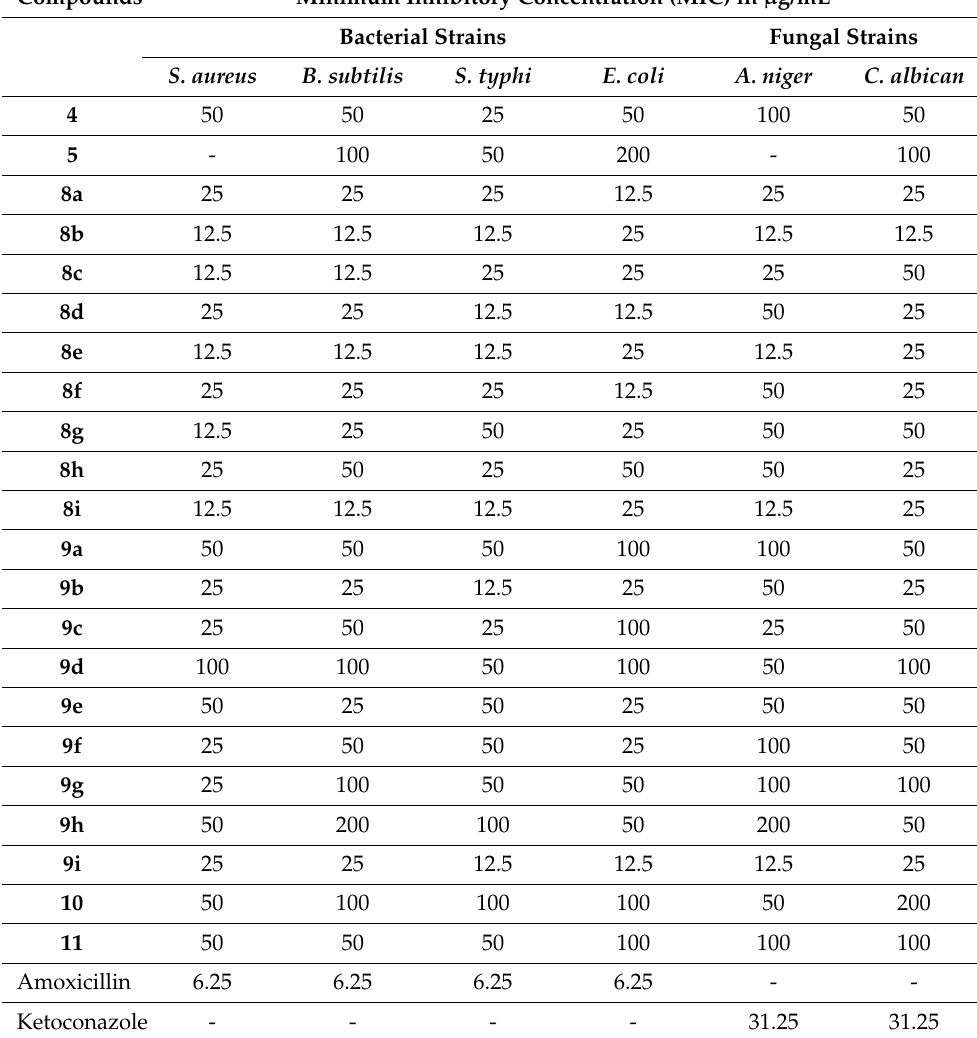
Table 1. Antimicrobial activity of compounds 4 , 5 and 8 – 11 .